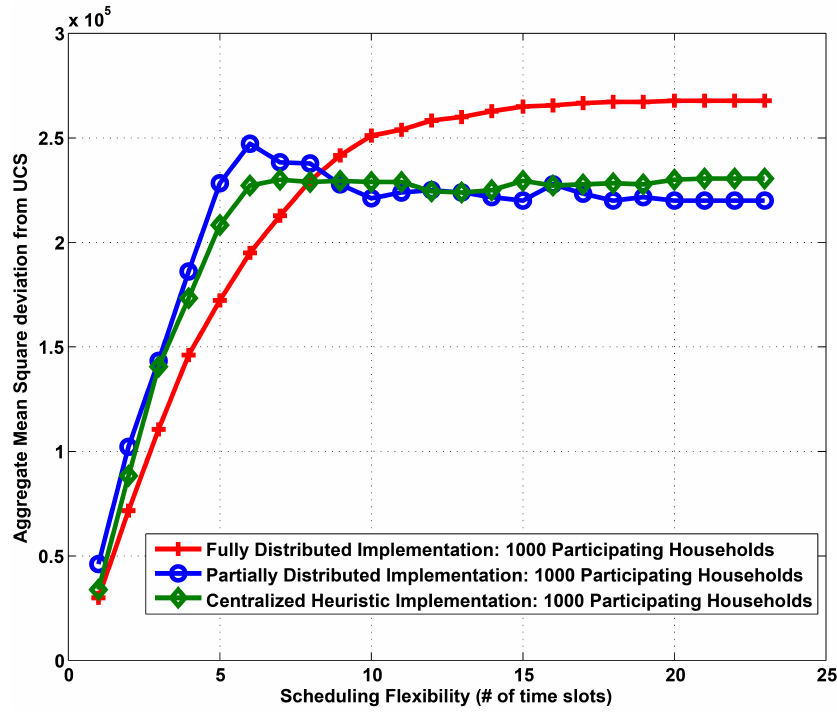
Figure 4. Aggregate mean square deviation from UCS vs . scheduling flexibility: 1000 participating